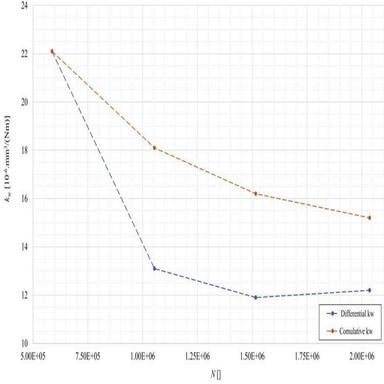
Wear coefficient dependence on load cycles.